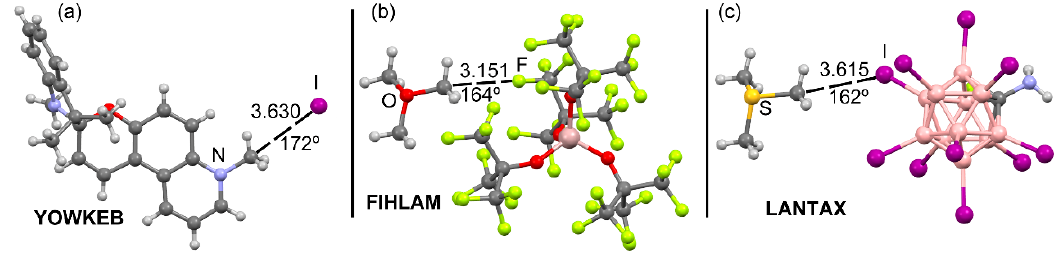
Figure 9. X-ray structures of CSD refcodes. ( a ) YOWKEB; ( b ) FIHLAM; ( c ) LANTAX. Distances in Å are given adjacent to the dashed lines used to represent the TtBs.